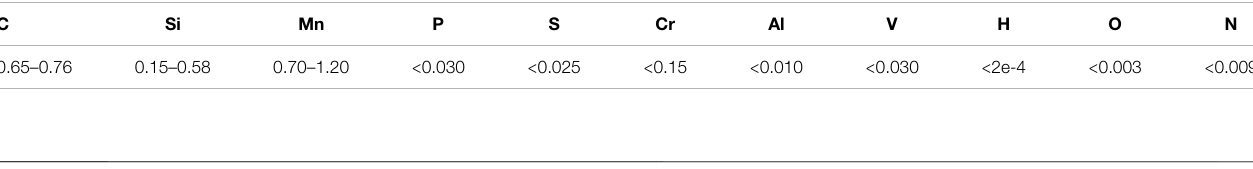
TABLE 1 | Chemical composition (wt%) of U75V steel (the balance is Fe).